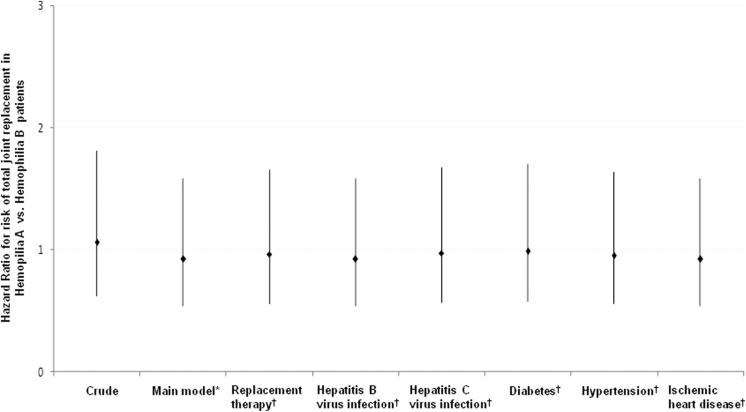
Sensitivity analyses of total joint replacement rate between patients with hemophilia A
and hemophilia B. *Main model is adjusted for age, human immunodeficiency virus
infection, and pyogenic arthritis. †The models are adjusted for covariates in the main model as well as each
additional listed covariate.